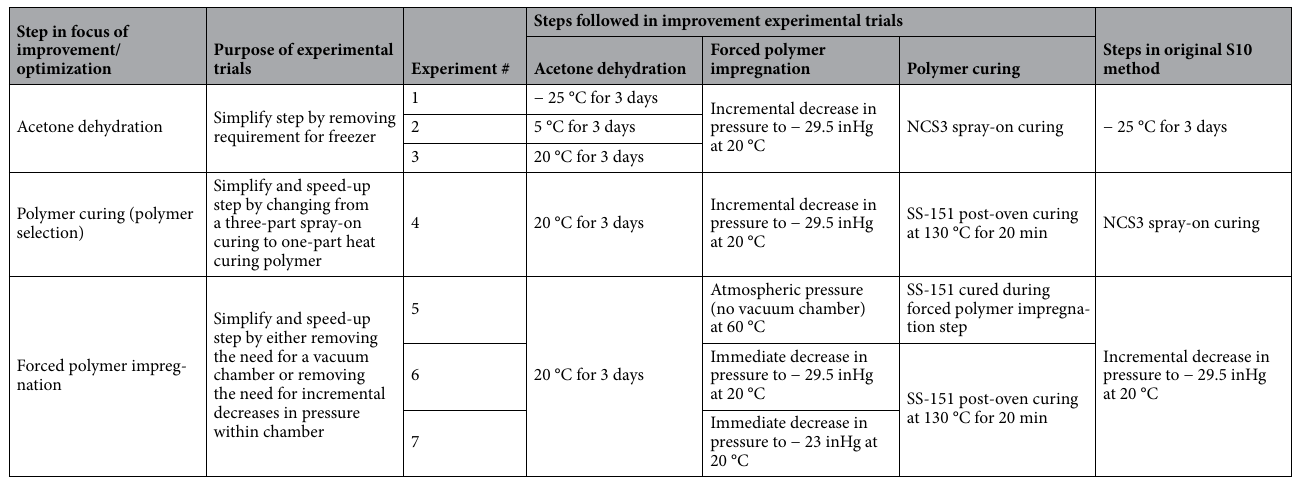
Table 1. Summary of improvement trial experiments performed and comparison to the original S10 plastination method. Note that, although polymer curing is the last step of the entire process, it needed to be optimized (i.e. selecting an alternative resin and recommend its curing profile) prior to the forced polymer impregnation trials, as the latter must use the same selected